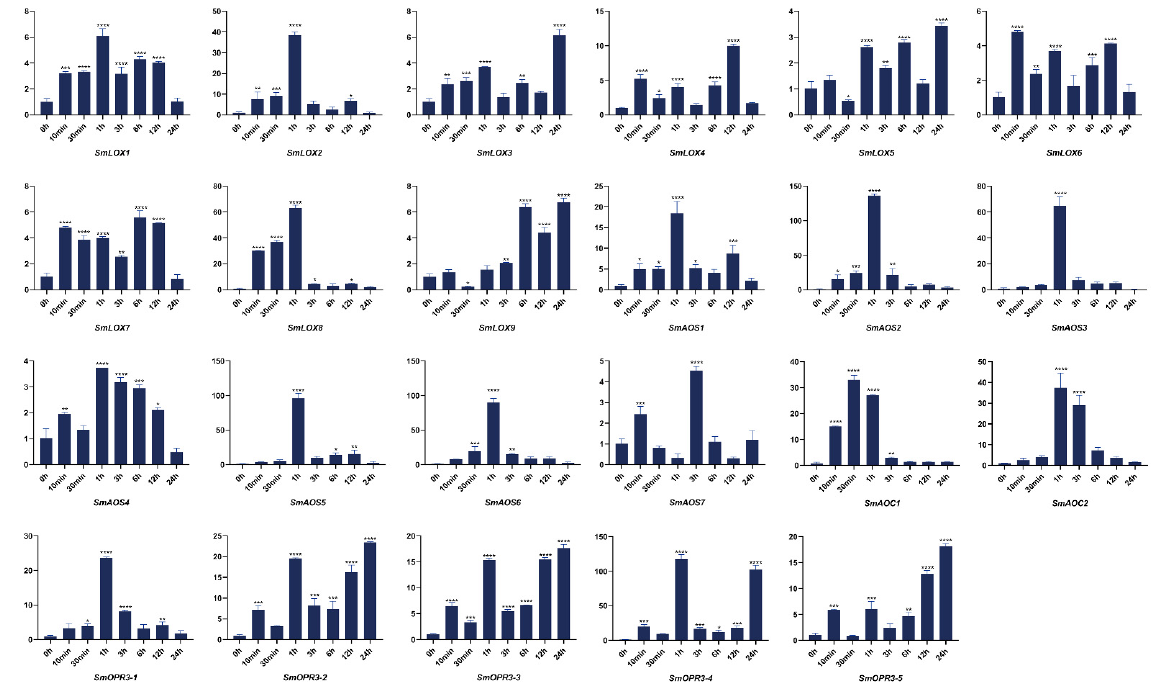
Figure 6. Expressions of JA biosynthesis related genes were correlated at 0 h, 10 min, 30 min, 1 h, 3 h, 6 h, 12 h, and 24 h following the S. miltiorrhiza injury treatment. The transcript levels were analyzed using the qRT-PCR method. Asterisks ( p < 0.05) indicate significant differences compared with the control group (* p < 0.05, ** p < 0.01, *** p < 0.001, **** p < 0.0001).